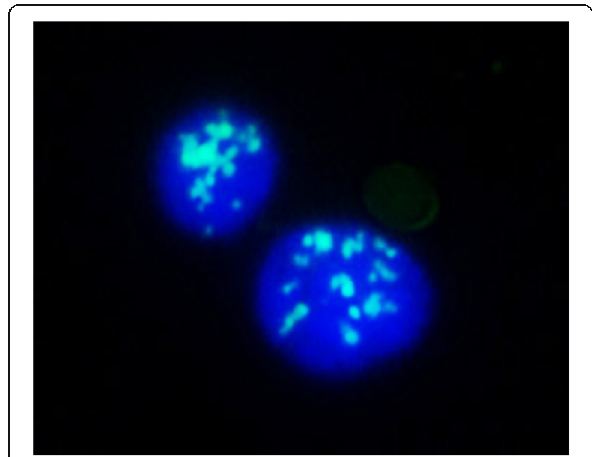
Fig. 5 MeFISH image for major satellite region in mouse embryonic stem cells after osmium treatment and denaturation (green, ICON probe; blue,